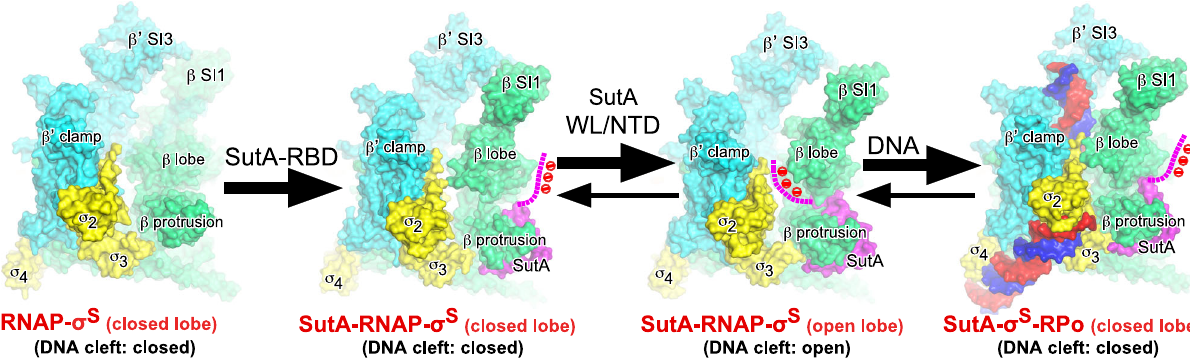
Fig. 7 The proposed model for transcription activation by SutA. RNAP- β lobe of RNAP holoenzyme is in rapid equilibrium between open and closed conformation but with preference on being closed. SutA anchors RNAP- β protrusion through its RBD and wedges open β lobe through its wedge loop to facilitate RPo The protein expression was induced with 0.4mM IPTG at 18 °C for 20 h at OD 600